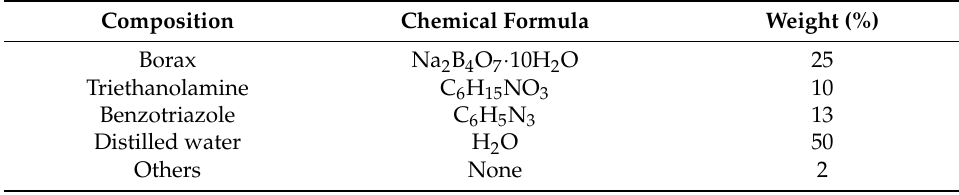
Table 2. Composition ratio of the strengthened grinding fluids.